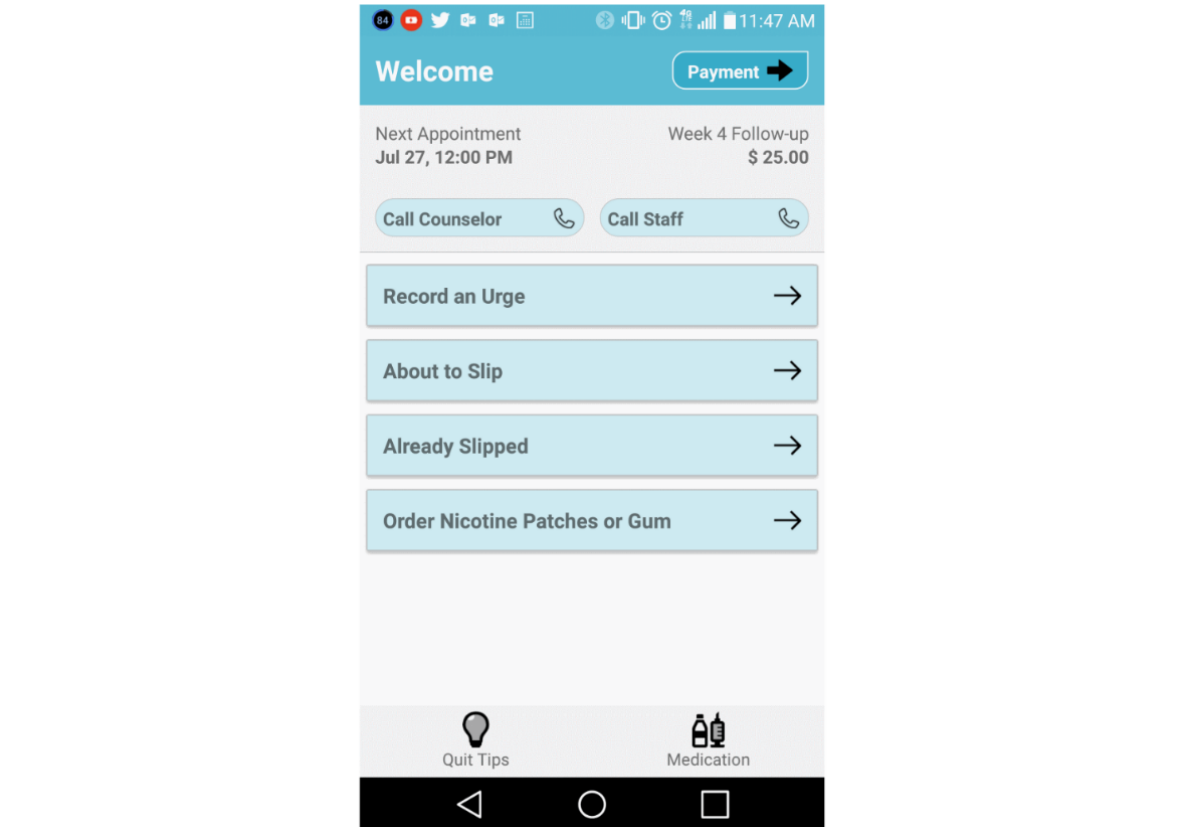
Figure 1. The Smart-Treatment app home